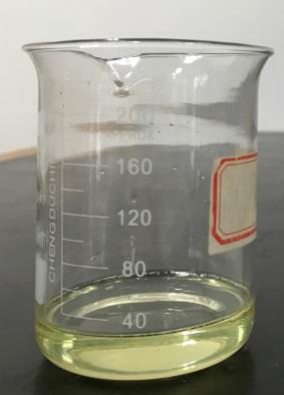
Figure 2. Photograph of polyurethane organic polymer. Table 3. Properties of polyurethane organic polymer.